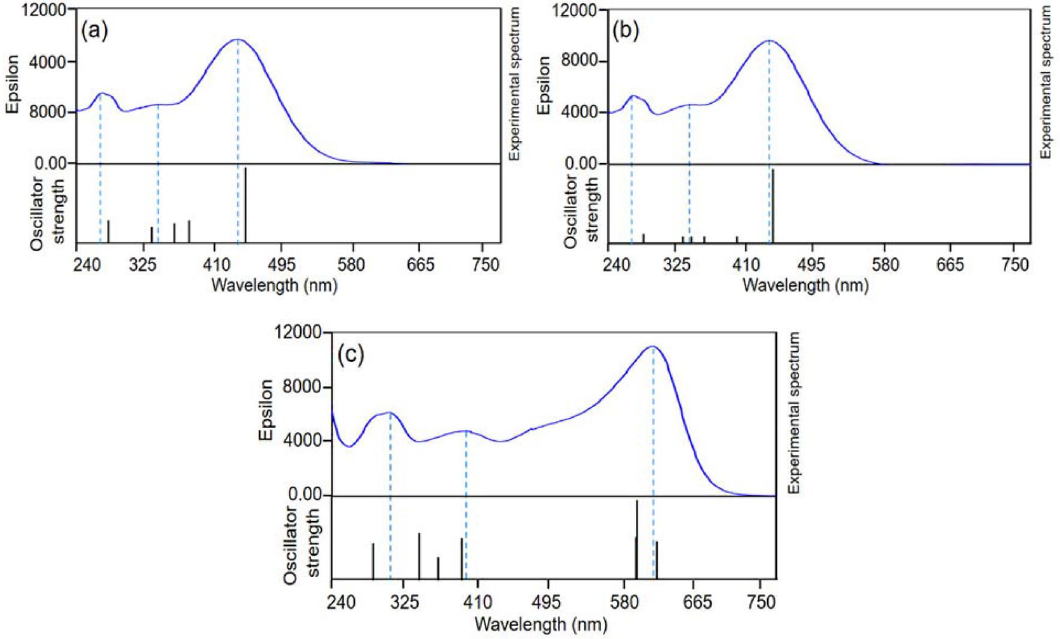
Figure 3. Computed wavelengths (black) and experimental spectrum (blue) for: ( a ) MTB H4 , ( b ) MTB H6 and ( c ) MTB H0